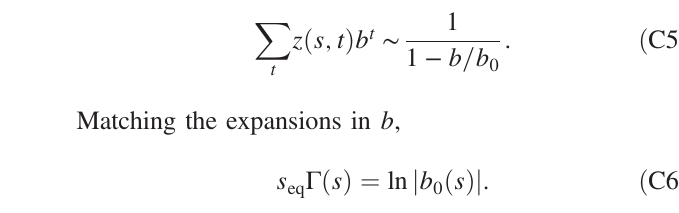
FIG. 21. The diffusive decay of Ising model in Eq. (80). Both axes are